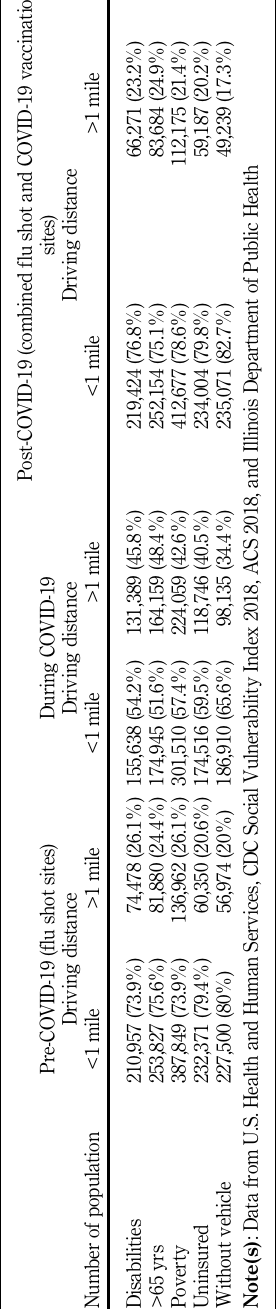
Table 1. Percent of vulnerable populations less than and greater than one mile away from flu, COVID-19